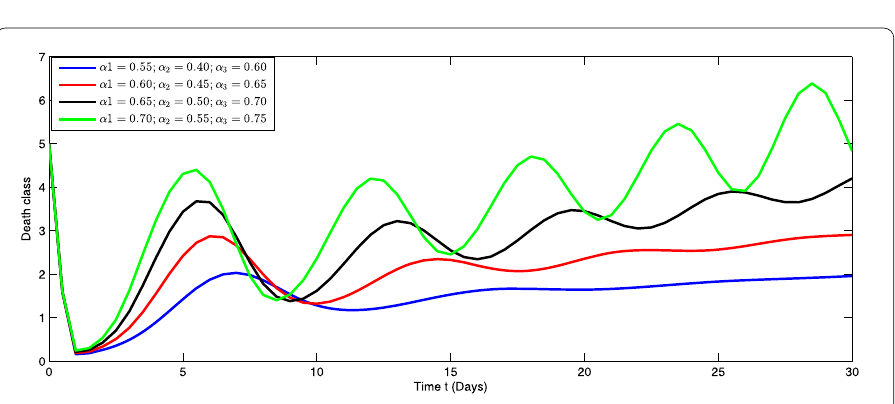
Figure 10 Dynamical behavior of D for different values of α i ( i = 1,2,3) at integer